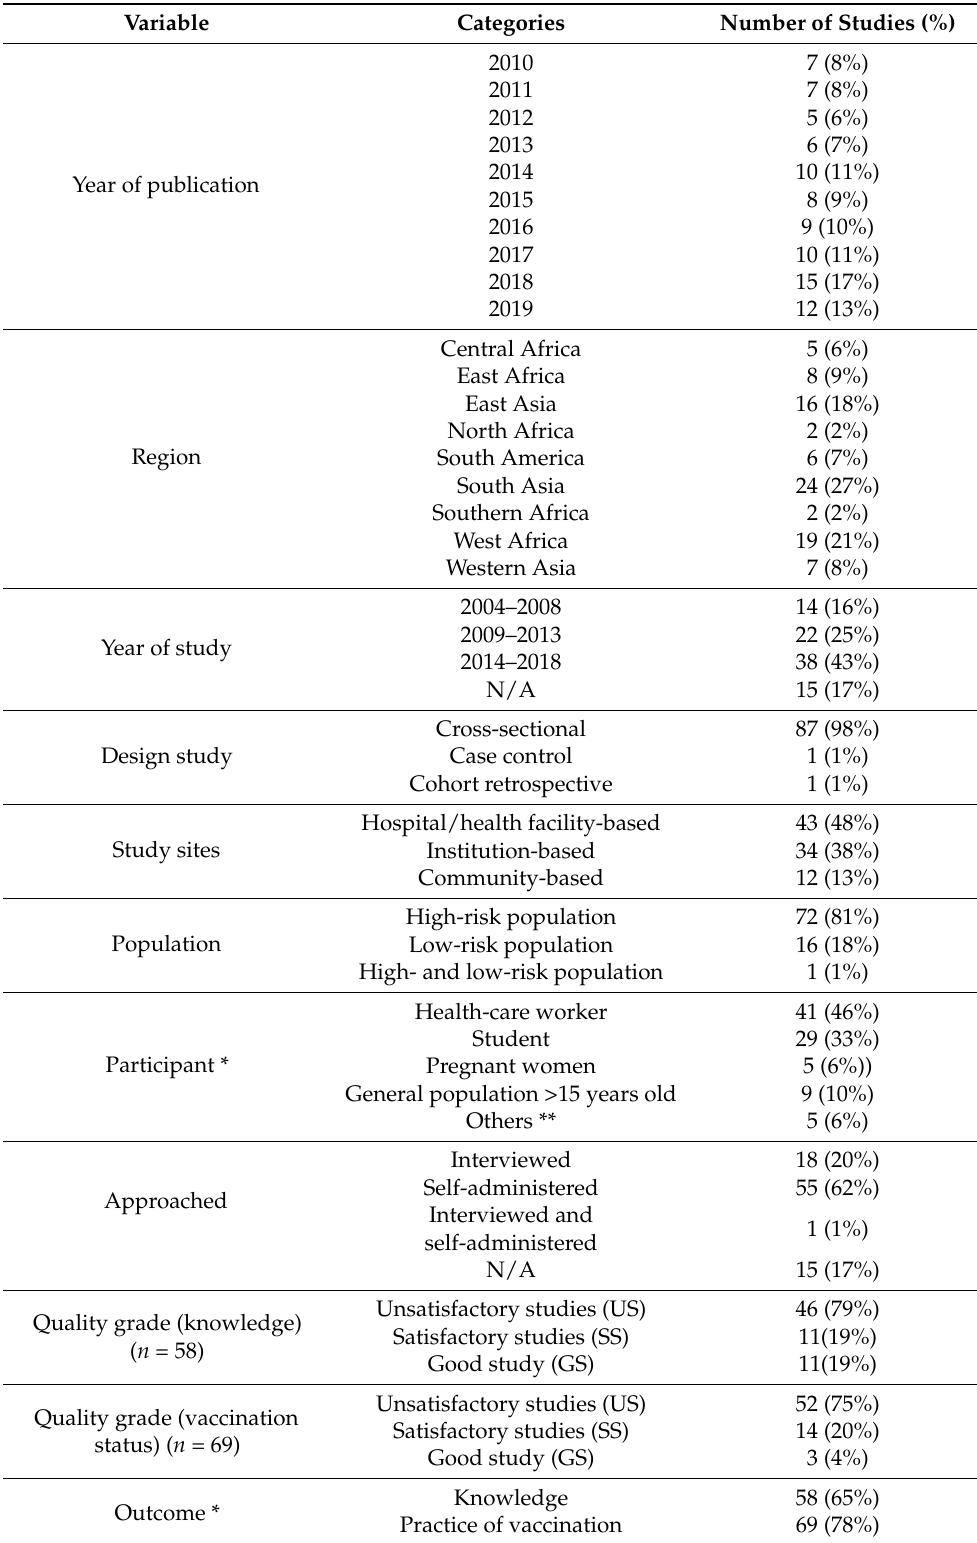
Table 1. Summary of